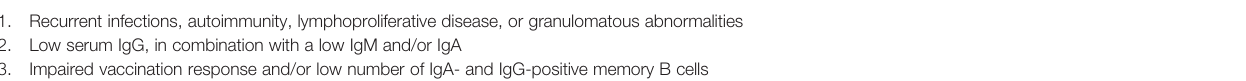
TABLE 2 | De fi nition of CVID.